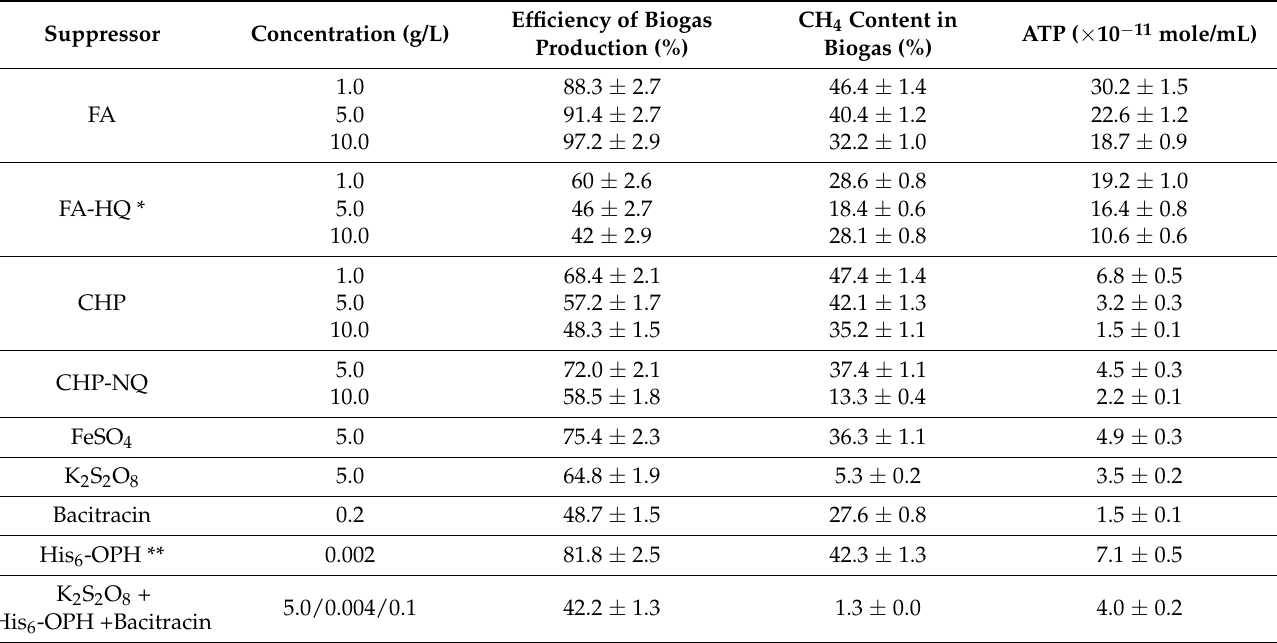
Table 5. Effect of various suppressors on the action characteristics of natural methanogenic con- sortia (biogas production, CH 4 content, and intracellular ATP concentration).